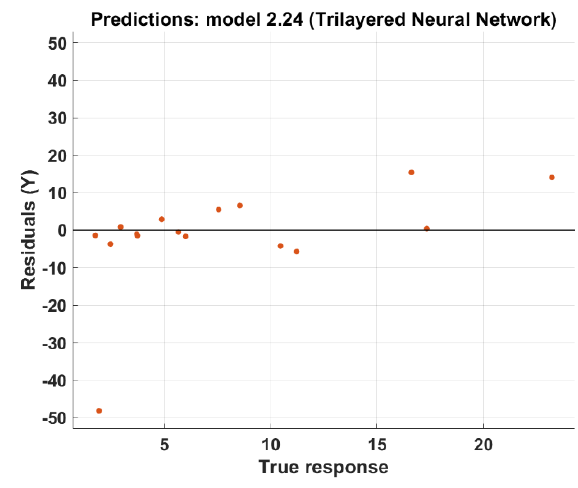
Figure 3. The model predictions for the test set.